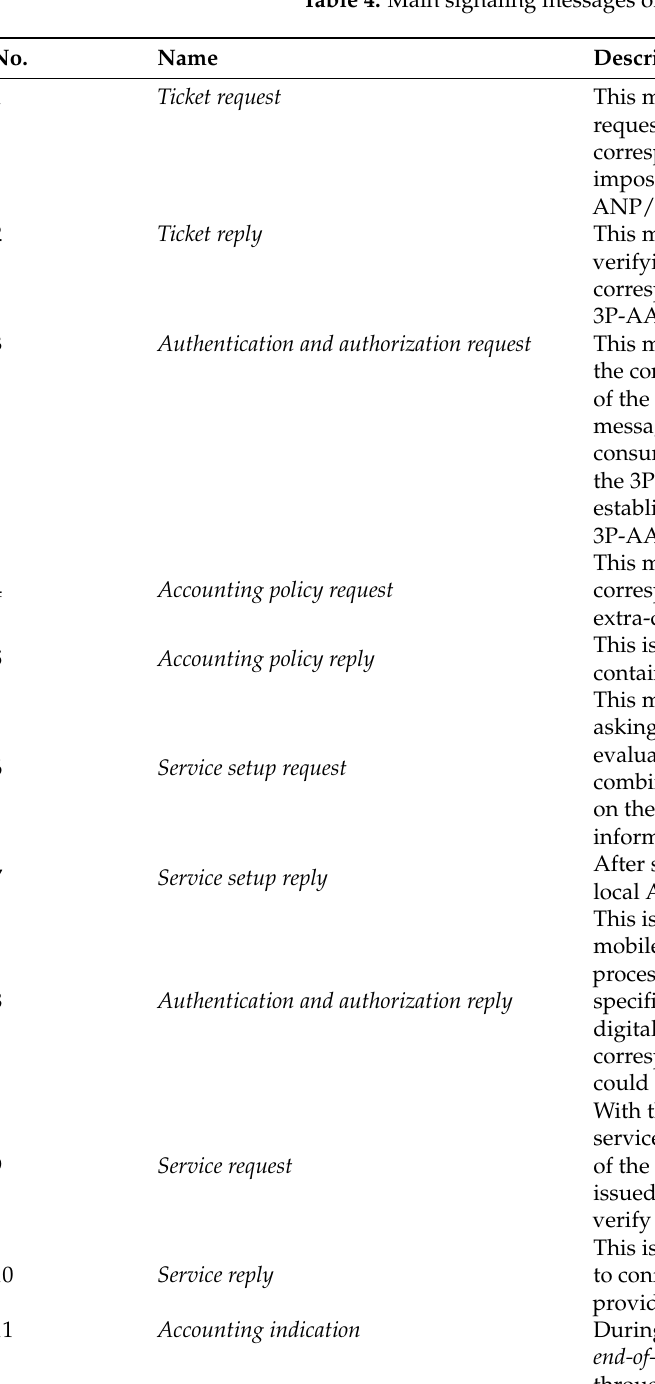
Table 4. Main signaling messages of the push authorization